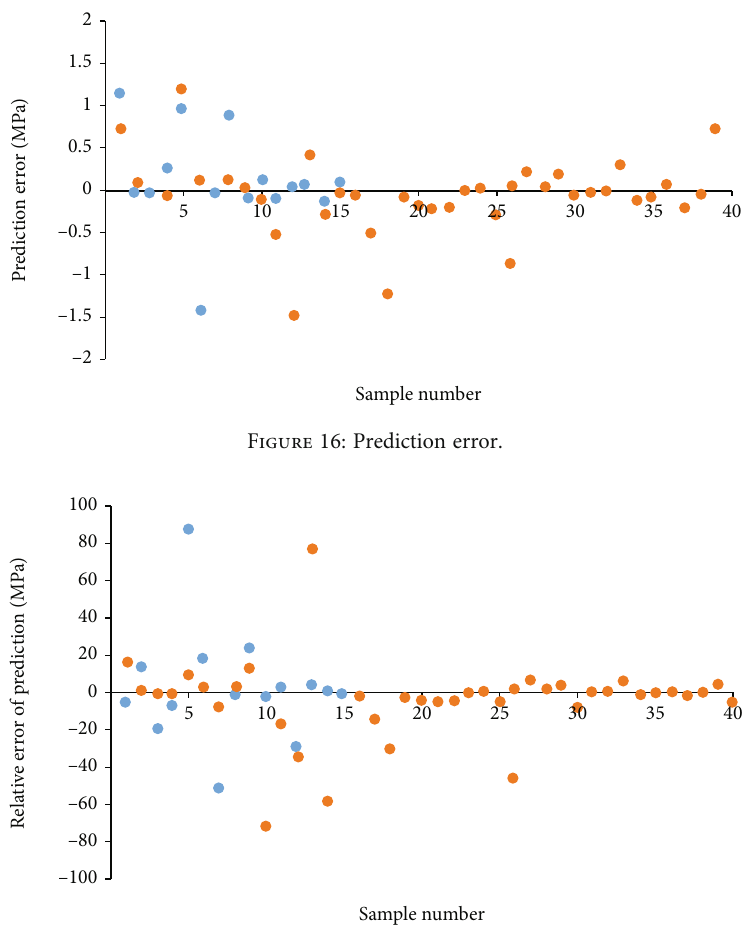
Figure 17: Prediction relative